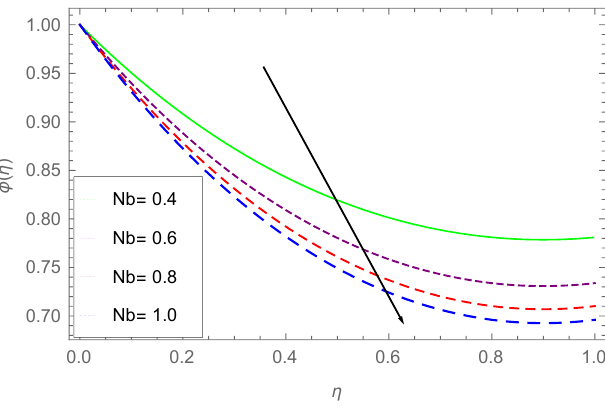
Figure 11. Impact of Nb on φ ( η ) , when Sc = 0.7, (cid:101) = 0.1, β = 0.9, S = 0.7, Nt = 0.3, Pr =